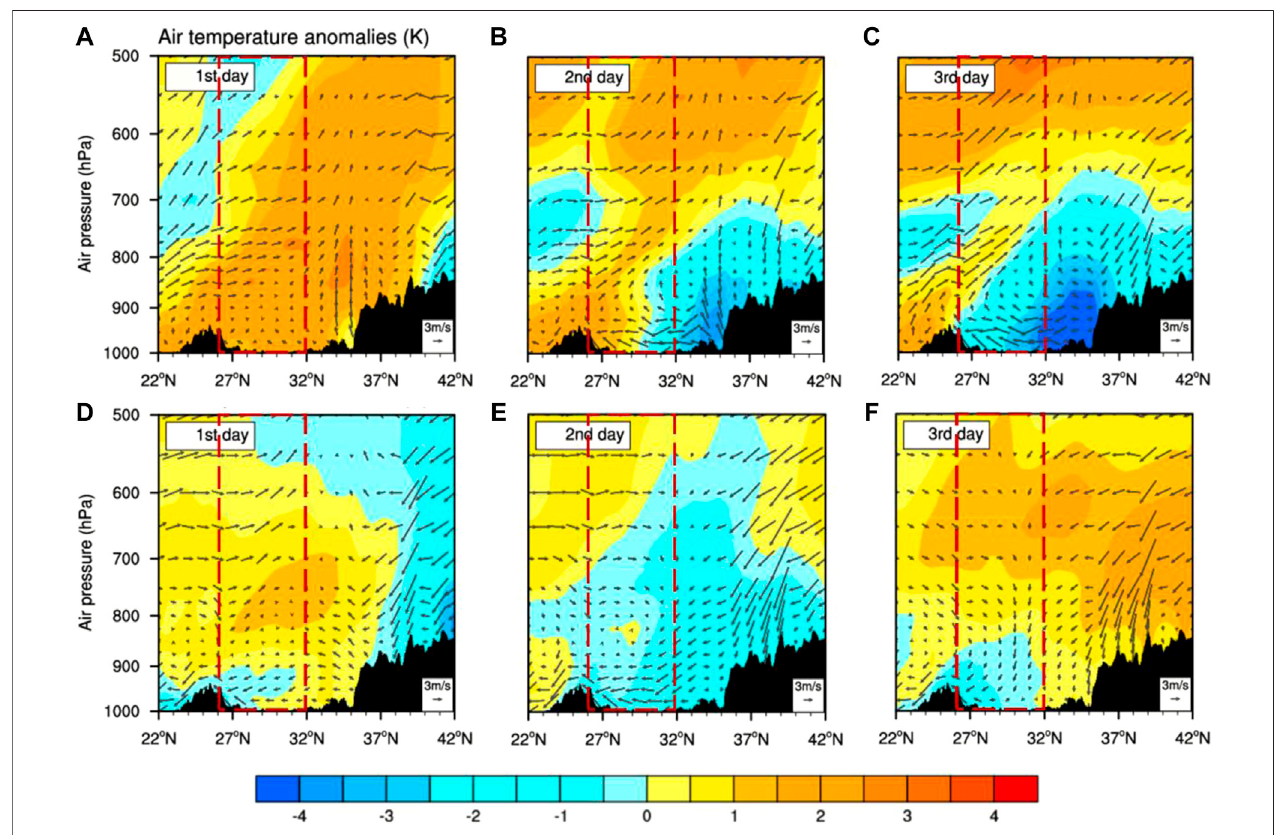
FIGURE 7 | Vertical (height-latitude) cross sections of air temperature anomalies (color contours; ° C), wind vectors (arrow), and terrain (black shades) along the 112 ° E – 114 ° E averaged during the heavy air pollution process averaged over six severe PM 2.5 episodes of the top row (A,B,C) RTT and bottom row (D,E,F) SAT. Red dotted frames denote the locations of the THB. Notably, the vertical speed of wind vectors is multiplied by -40 for the illustration of vertical circulation.